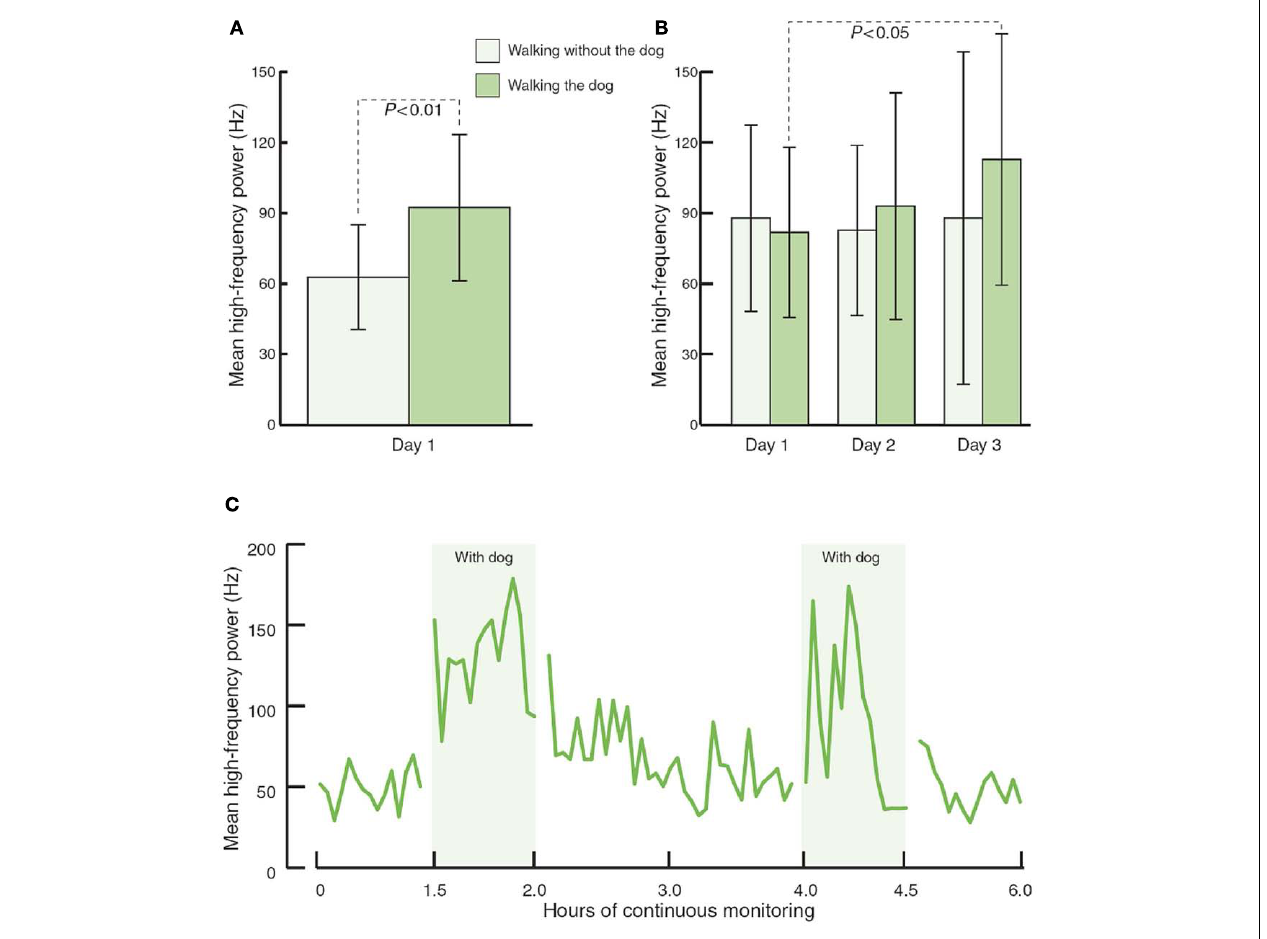
( n =13). (B) 80-min walking programme over three consecutive days ( n = 3). (C) Interaction with the dog at home during 6h of continuous monitoring ( n =4).